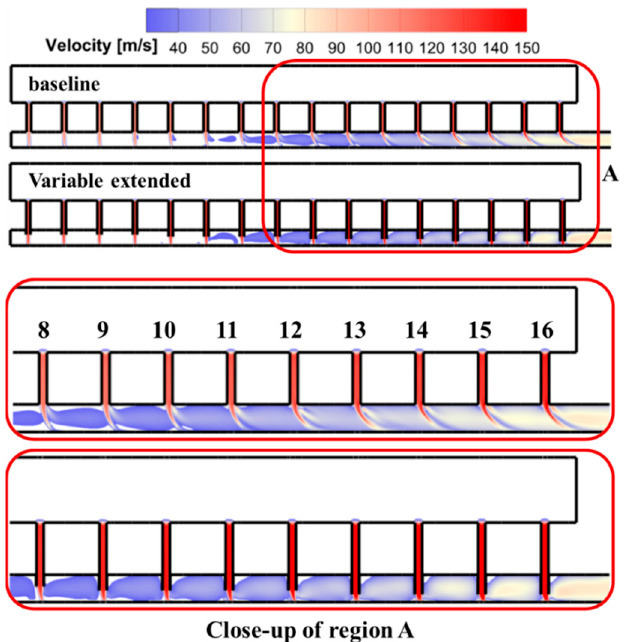
Figure 12. Jet velocity distributions on the streamwise centerline plane, Re j = 2.0 × 10 4 .